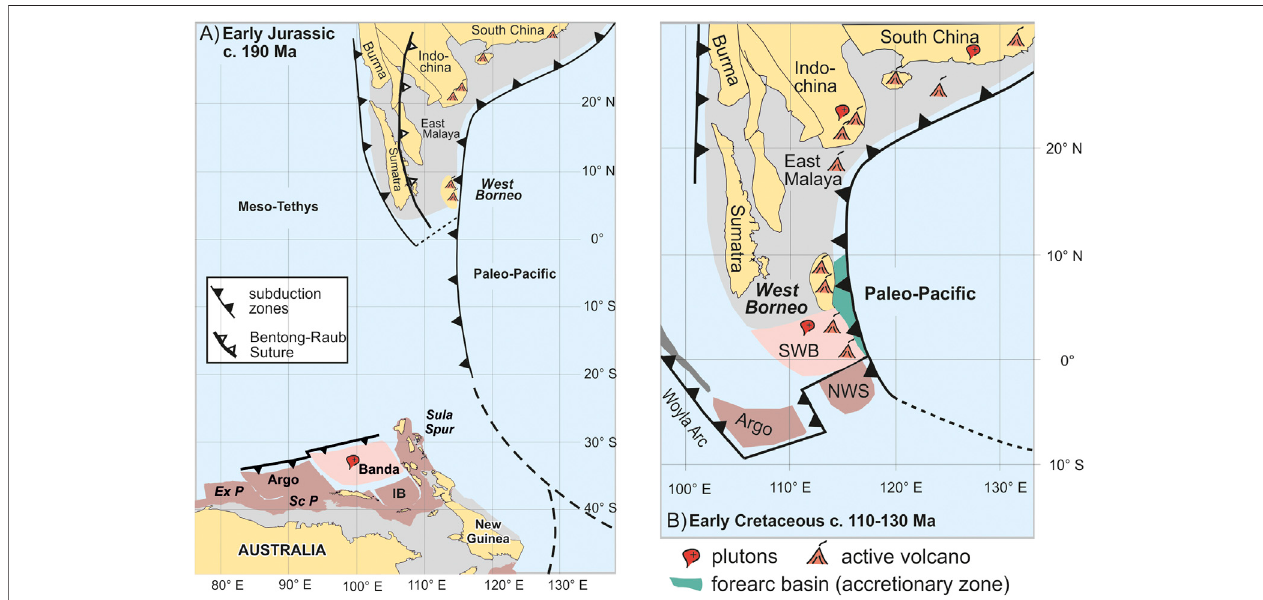
FIGURE 3 | Paleogeography maps (modi fi ed from Hall, 2012; Hennig et al., 2016; Hennig et al., 2017), showing (A) beginning of separation of the Banda (SW Borneo, SWB) and Argo blocks from NW Australia. Rifting began in the Triassic or Early Jurassic and the blocks fi nally separated in the Middle to Late Jurassic. The Paleo-Paci fi c subduction margin followed the eastern side of Sundaland and South China, and (B) accretion of SW Borneo to Sundaland before c. 135 Ma and continuation of subduction-related magmatism associated with the Paleo-Paci fi c in West Borneo and initiation of magmatism in SW Borneo that formed the Menunuk Volcanics, Sepauk Tonalite, and Pinoh Metamorphic Group between c. 130 to 110 Ma. Subduction ceased later with the collision of the Argo Block with SW Borneo around 90 Ma. NWS (Northwest Sulawesi-East Sabah) is the Inner Banda Block (IB). ExP — Exmouth Plateau, ScP — Scott Plateau. Forearc basin fi ll by the Pedawan and Selangkai